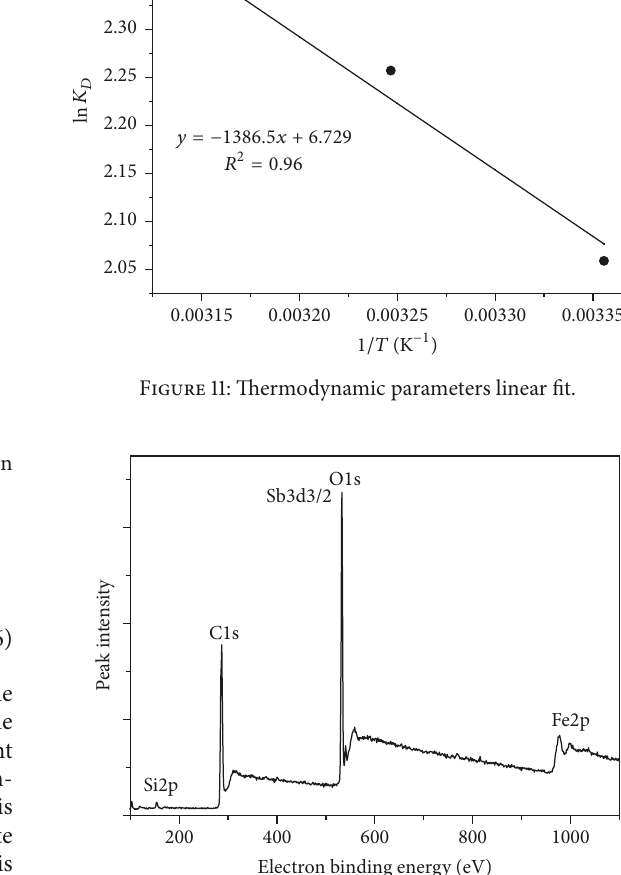
Figure 12: The total element distribution spectrum after adsorption